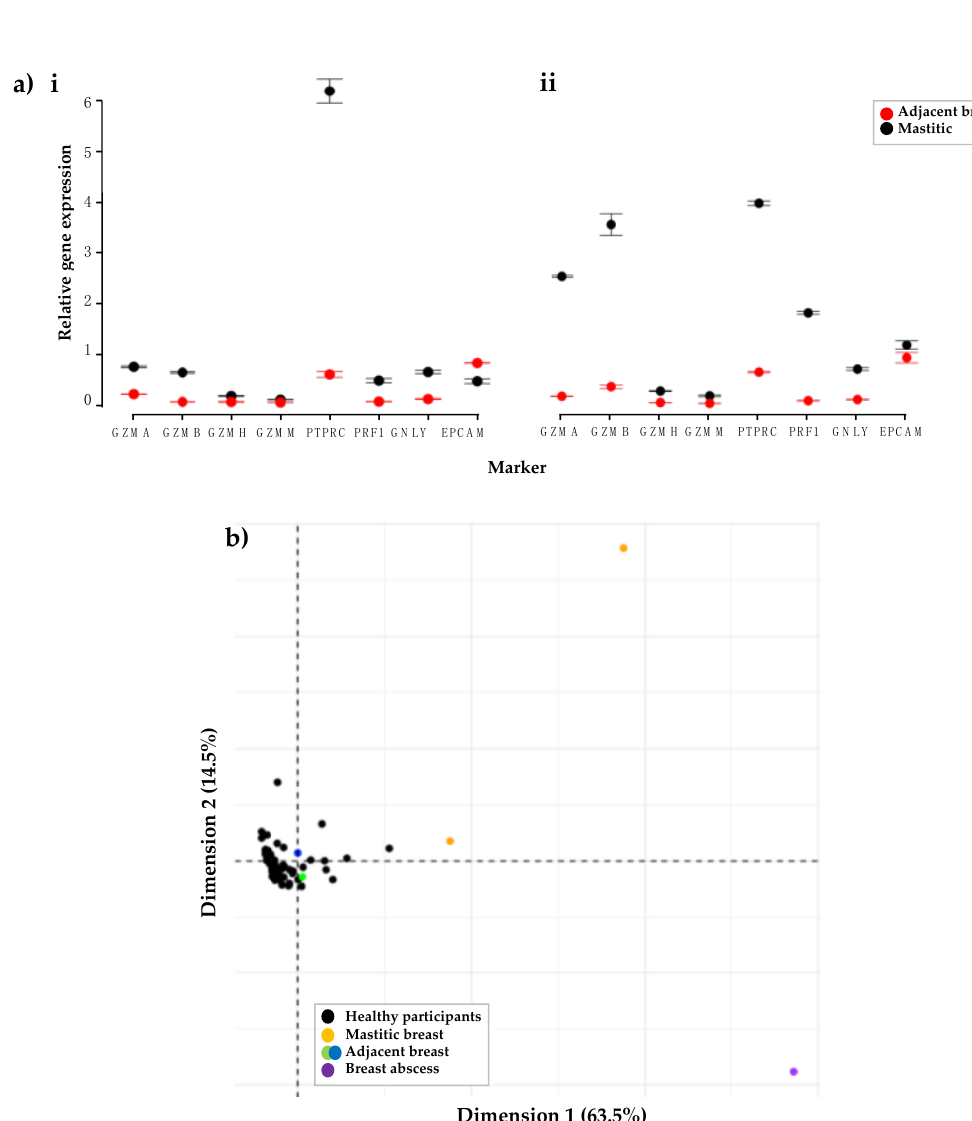
Figure 4. Comparisons of gene expression of immune genes in HM cells taken under different conditions. ( a ) Compares gene expression of HM cells taken from two participants ( i and ii ) with breasts affected by mastitis compared to the adjacent breast. PTPRC gene expression was upregulated in both participants ( i and ii ), whereas GZMA, GZMB and PRF1 was higher only in the second participant. Error bars represent the calculated standard error of the mean. ( b ) Principal component analysis (PCA) of the variance found between immune related gene expression in human milk cells taken from healthy participants compared to those from participants with mastitis or a breast abscess.